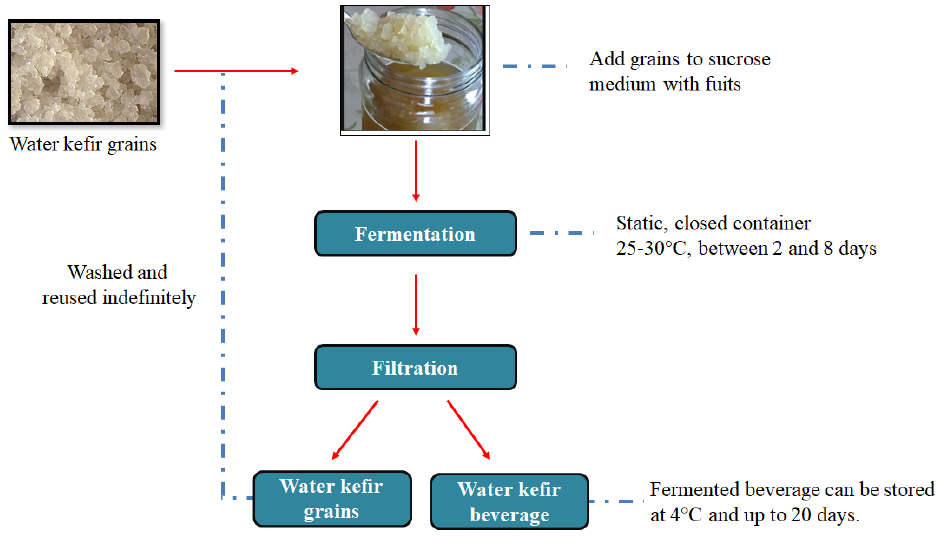
Figure 1. Traditional production of water kefir.